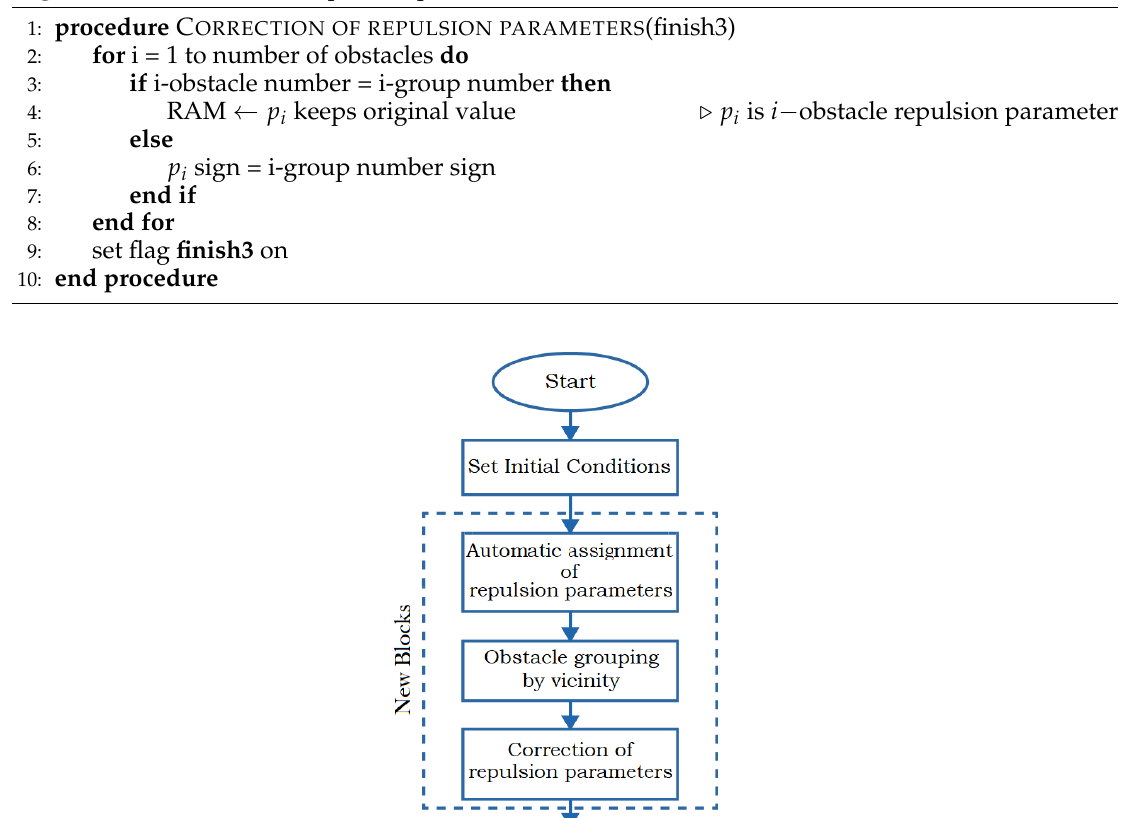
Algorithm 5 Correction of repulsion parameters